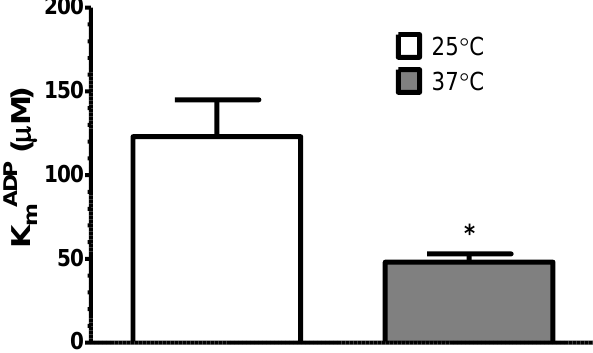
Figure 5. Influence of temperature on the apparent K mADP of saponin-permeabilized rat cardiac fibers oxidizing palmitoyl- L -carnitine (9 μM) in the presence of malate (0.24 mM). The results were analyzed with paired t test; n = 7; * p < 0.05.